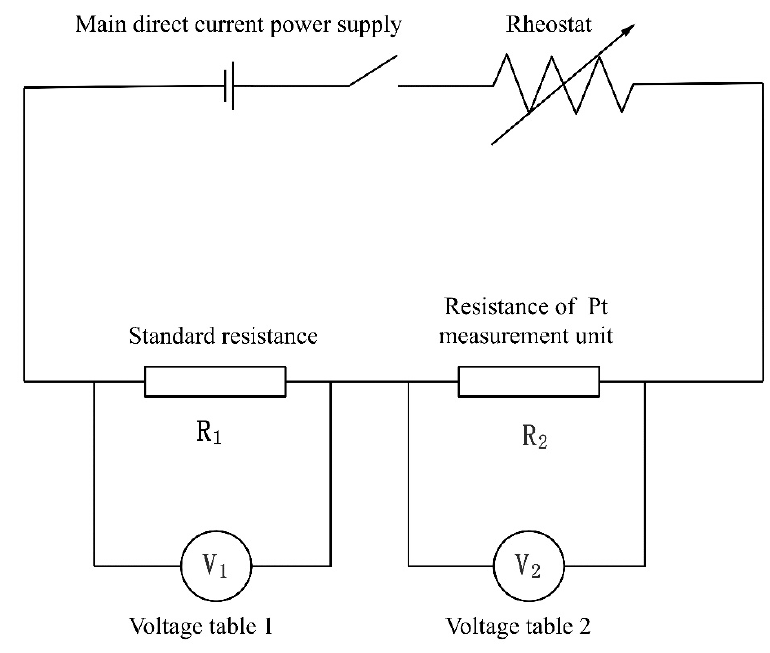
Figure 7. The experimental electrical circuit for thermal conductivity.